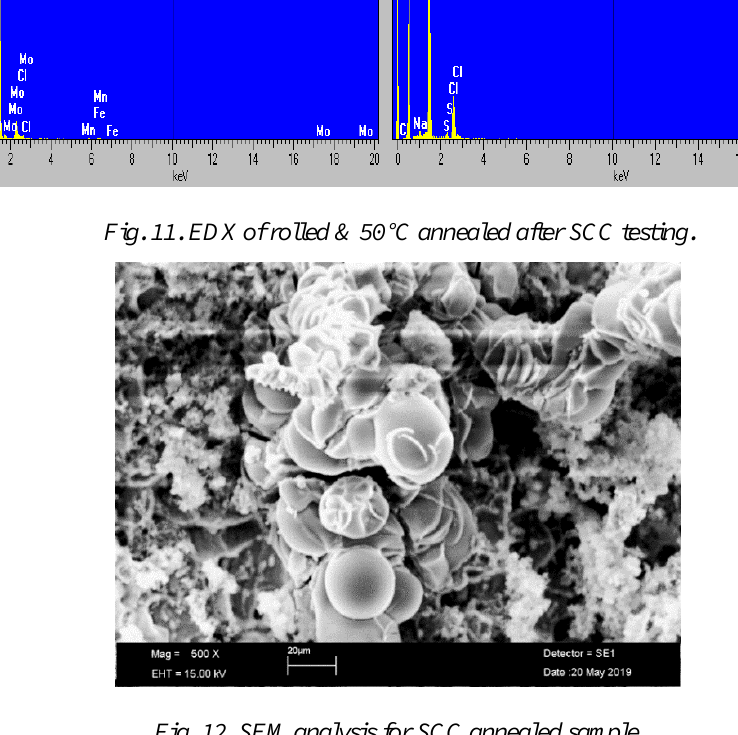
Fig. 12. SEM analysis for SCC annealed